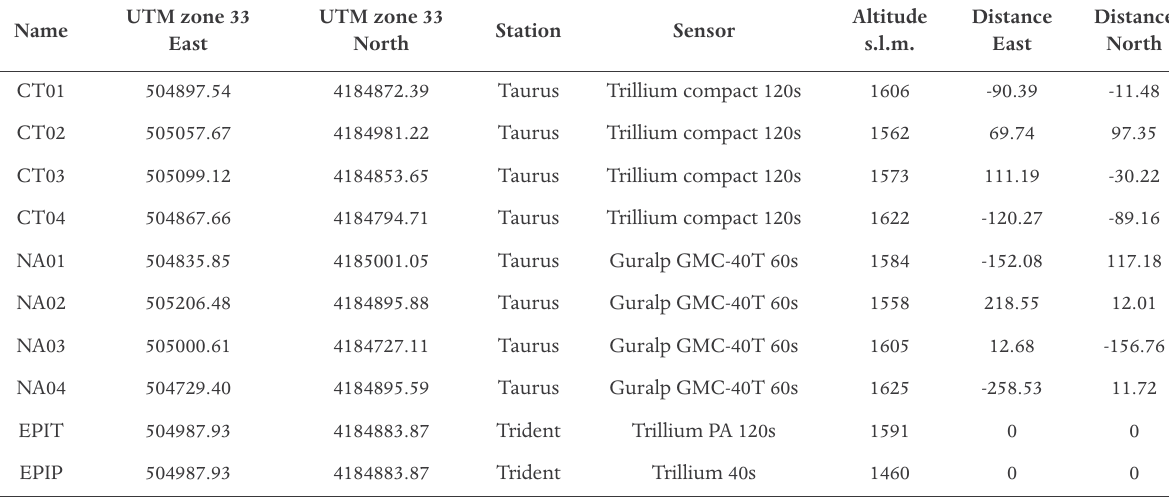
Table 2. Pozzo Pitarrone seismic array (May 2014 - October